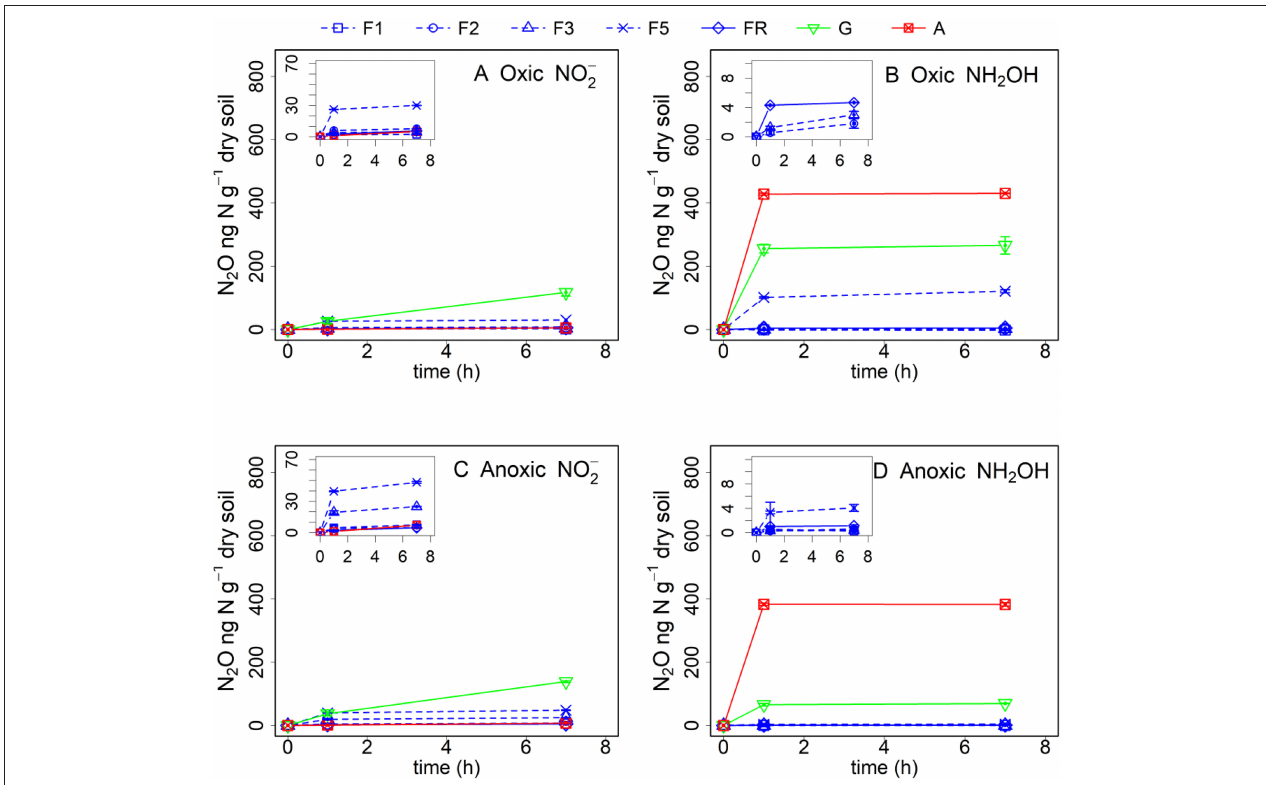
FIGURE 2 | Net N 2 O (ng N g − 1 dry soil) production in forest (F1, F2, F3, F5, and FR), grassland (G) and arable land (A) soils after γ -irradiation and NO − 2 ( A : oxic, C : anoxic pre-incubation) and